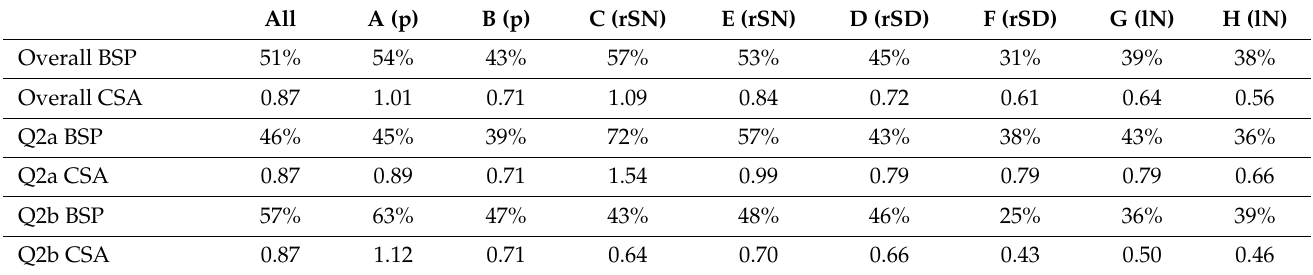
Table 3. BSP and CSA for each group on Q2a, Q2b, and on